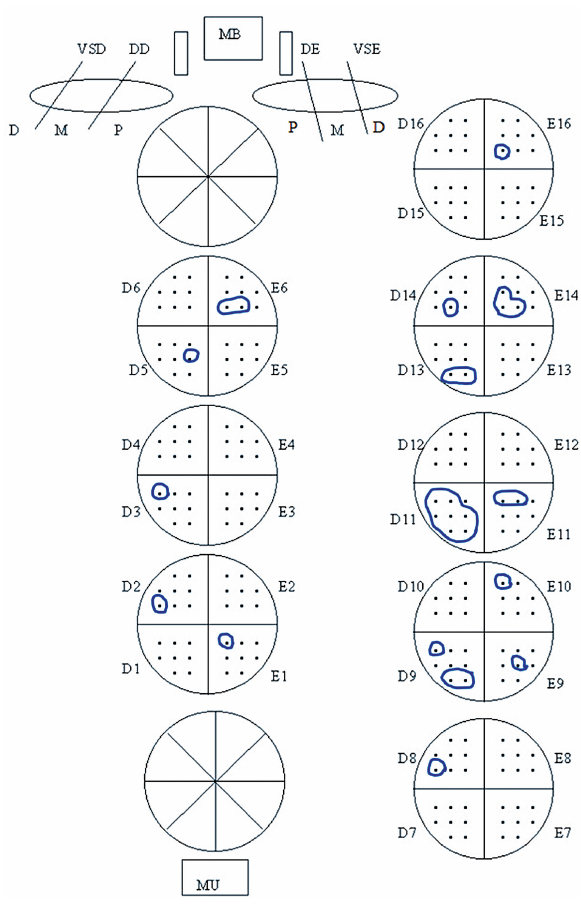
Figure 1 - Semiquantitative point count method to evaluate tumor extent. In this case, total tumor extent was recorded as 28 positive points. Quadrant D11 shows largest single cancer focus or dominant nodule of all quadrants, recorded as 7 index tumor positive points. The tumor is bilateral considering total tumor extent, and unilateral considering index tumor